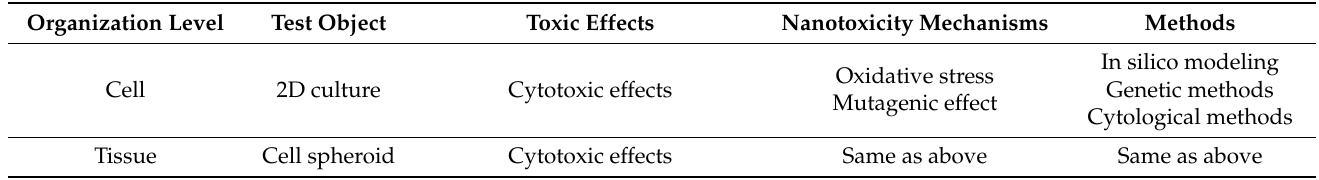
Table 5. Correspondence of models, toxic effects, and research